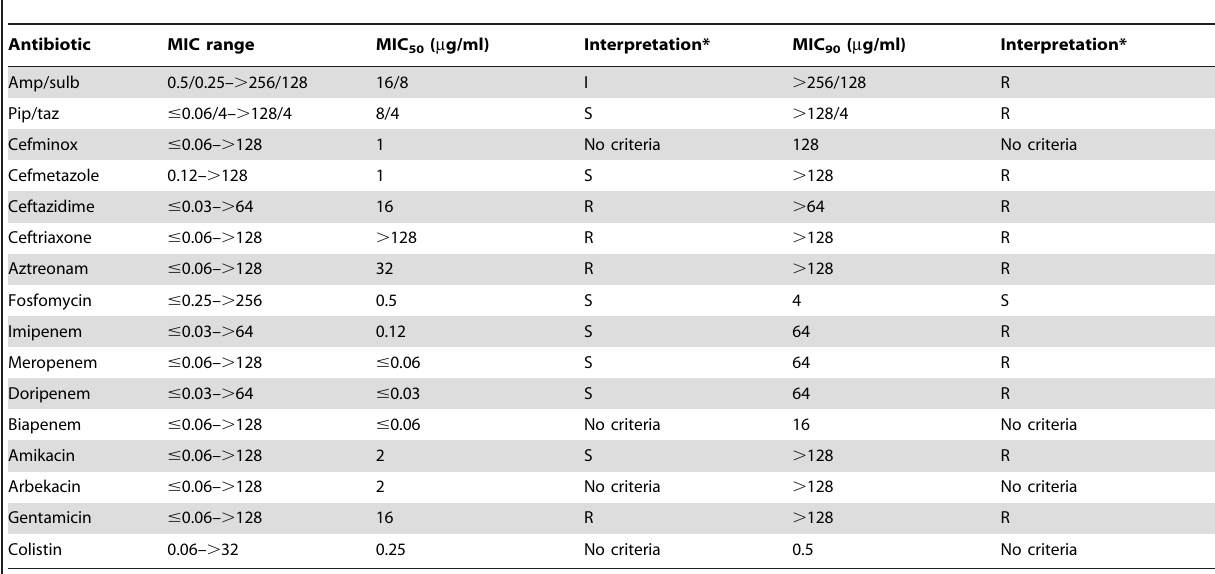
Table 2. Determination and interpretation of the MIC values of the antibiotics tested for Escherichia coli (n=211).